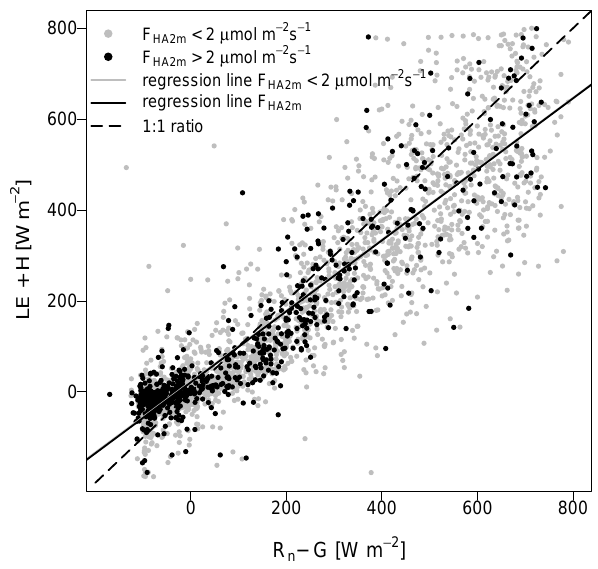
Fig. 10. Relationship between available energy (net radiation R n – ground heat flux G ) and turbulent fluxes (latent heat LE and sensible heat H ) for the period from May to August 2007. Grey circles indicate data points with advection < 2µmolm − 2 s − 1 , black circles represent data points with horizontal advection > 2µmolm − 2 s − 1 . The 1:1 regression line is given in grey. The regression lines of the data points are given in black and as they are nearly congruent appear as one single